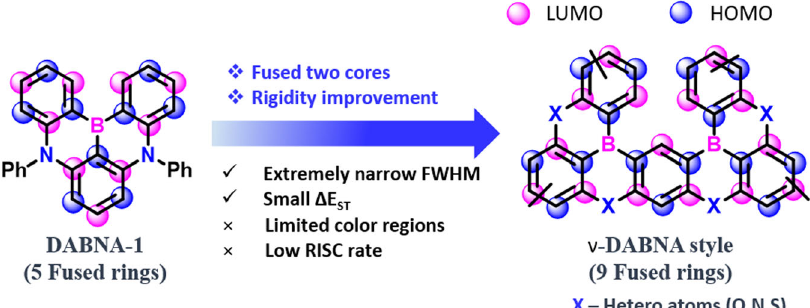
Fig. 1 DB-MR-TADF vs SB-MR-TADF. Merits of double boron embedded MR-TADF (DB-MR-TADF) emitters compare to single boron MR-TADF (SB-MR- TADF)